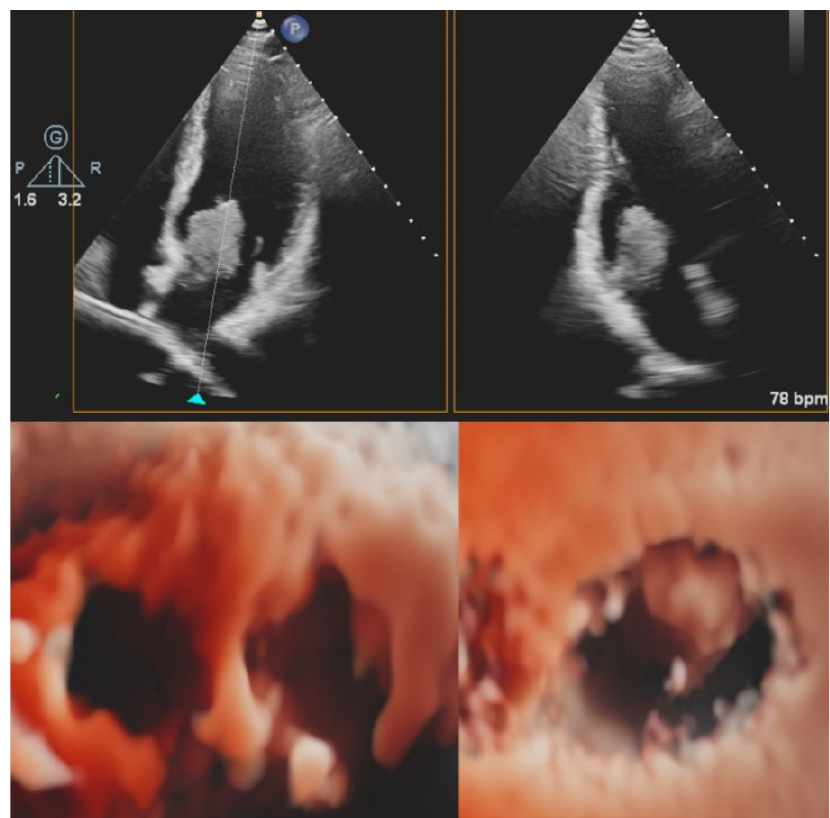
Fig. 1 - 2D transthorachic echocardiography images and 3D reconstruction of the left atrial mass.